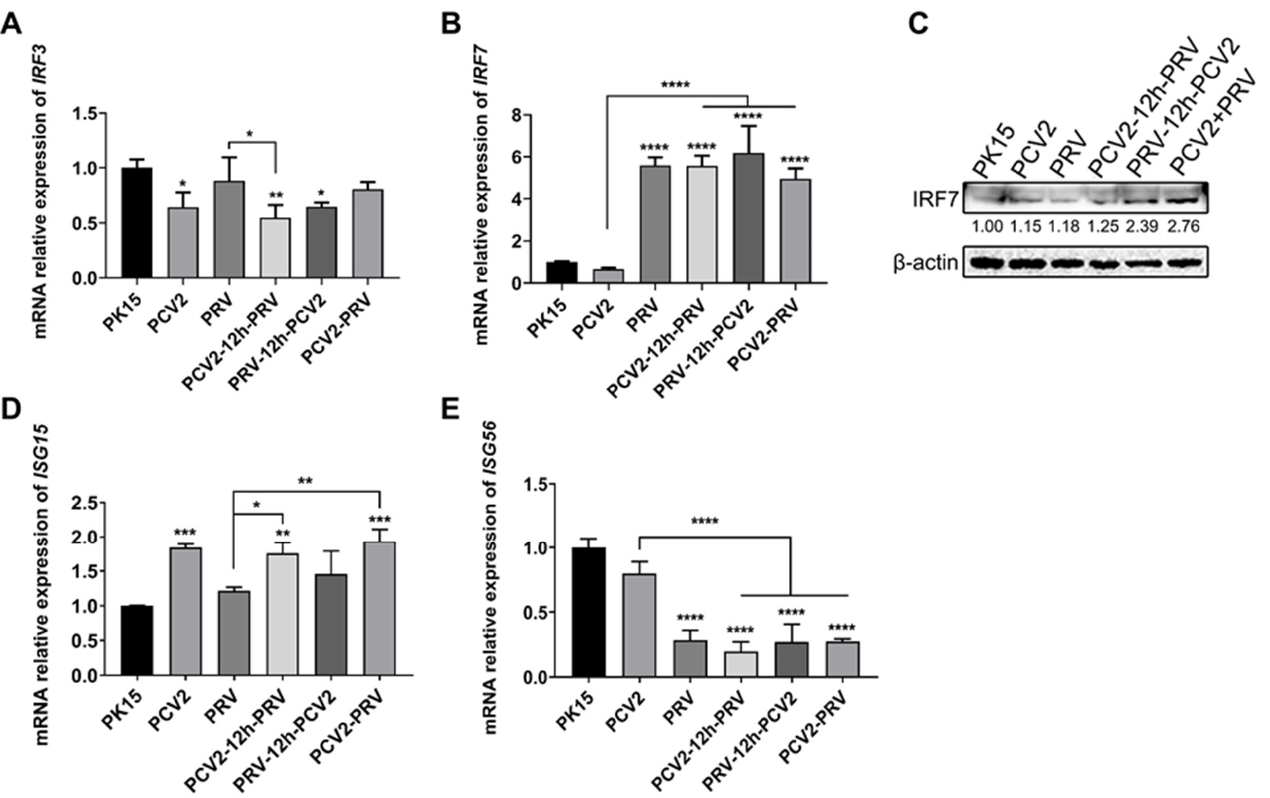
Figure 3. Coinfection of PCV2 and PRV regulates IRFs. ( A , B ) Expression levels of IRFs. The mRNA levels of IRF3 ( A ) and IRF7 ( B ) were evaluated via real-time PCR. ( C ) Protein levels of IRF7. Western blotting was performed using Rabbit Anti-IRF7 antibody and Anti- β -Actin Antibody as primary antibodies, respectively. HRP-labeled Goat Anti-mouse IgG (H+L) and HRP-labeled Goat Anti-rabbit IgG (H+L) were used as the secondary antibody. β -actin was used as a control. The average expression level of the target protein in each group is shown below each lane. The protein amount of the PK-15 group is set to 1, and the values of other groups are the ratio with the PK-15 group. ( D , E ) Expression levels of ISGs. The mRNA levels of ISG15 ( D ) and ISG56 ( E ) were evaluated via real-time PCR. *, p -value < 0.05; **, p -value < 0.01; ***, p -value < 0.001; ****, p -value < 0.0001. The data are